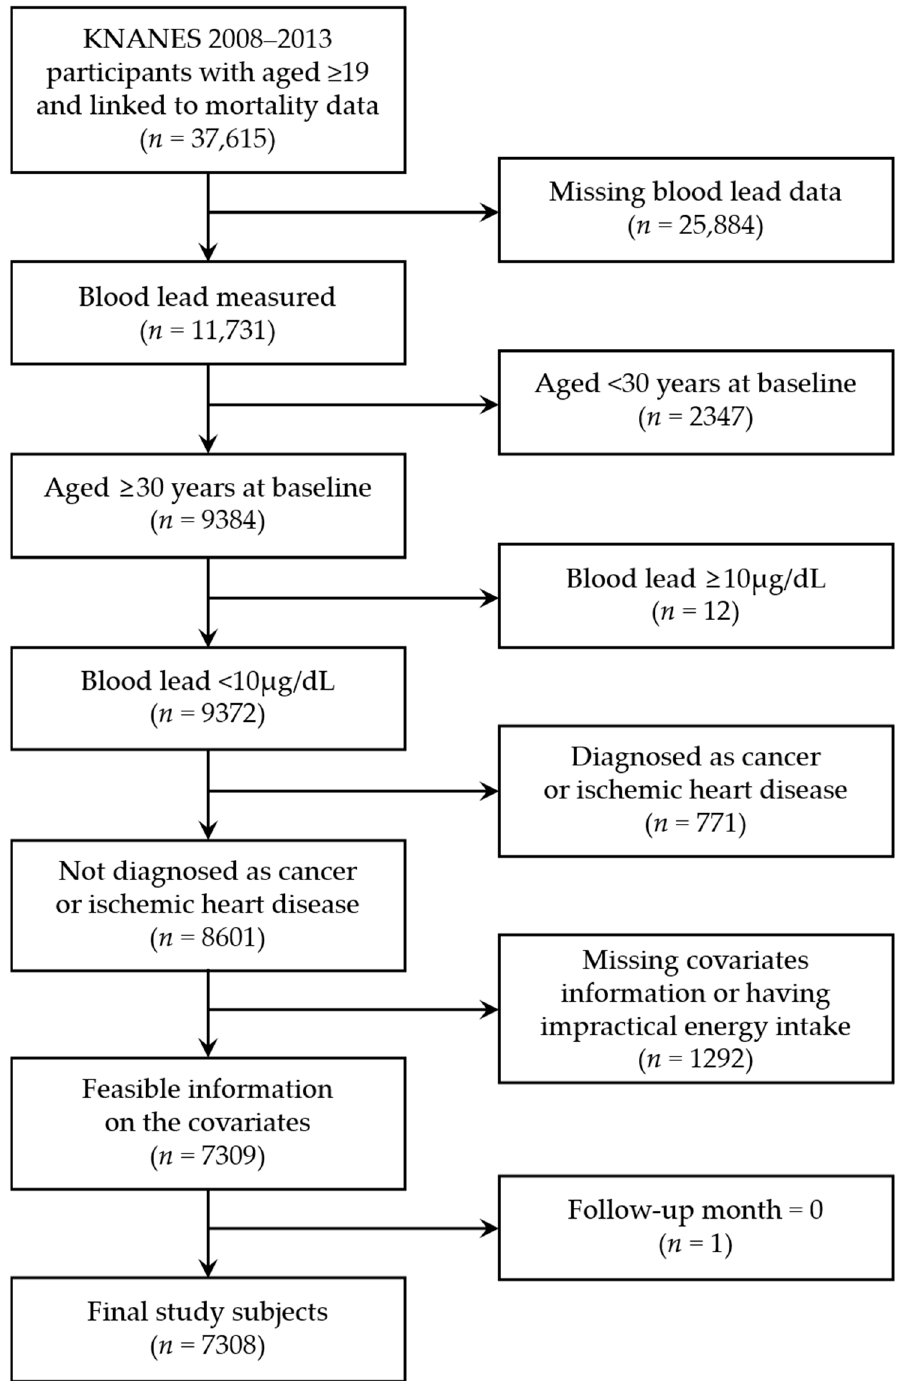
Figure 1. Flow chart of the selection process of study subjects from the Korea National Health and Nutrition Examination Survey.